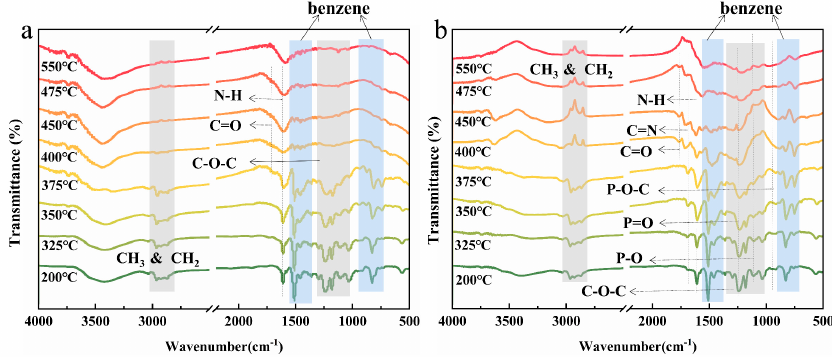
Figure 7. Infrared spectra of EP ( a ) and 3%TAD/1%Zn-PDH/EP ( b ) after being maintained at different temperatures for 15 min in a muffle furnace.